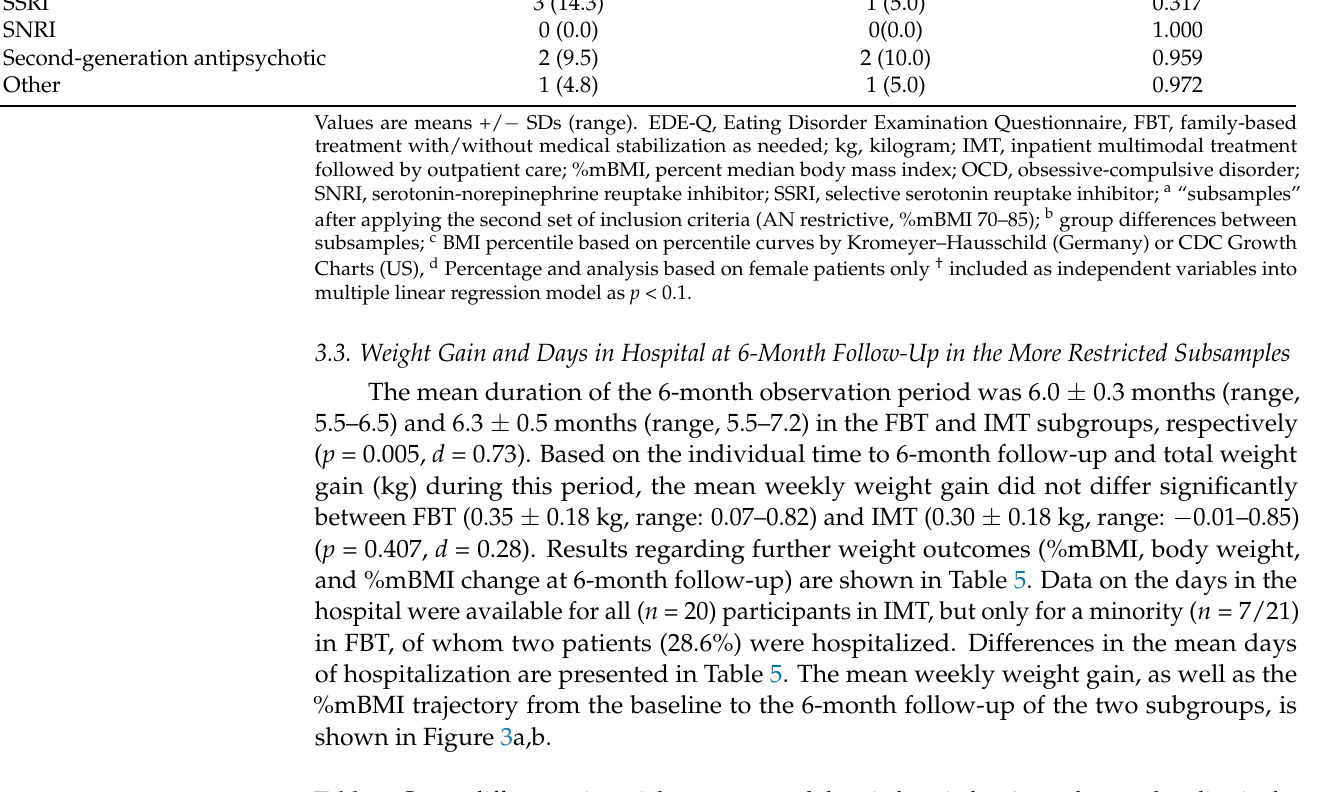
Table 5. Group differences in weight outcome and days in hospital at 6 months post-baseline in the FBT and IMT